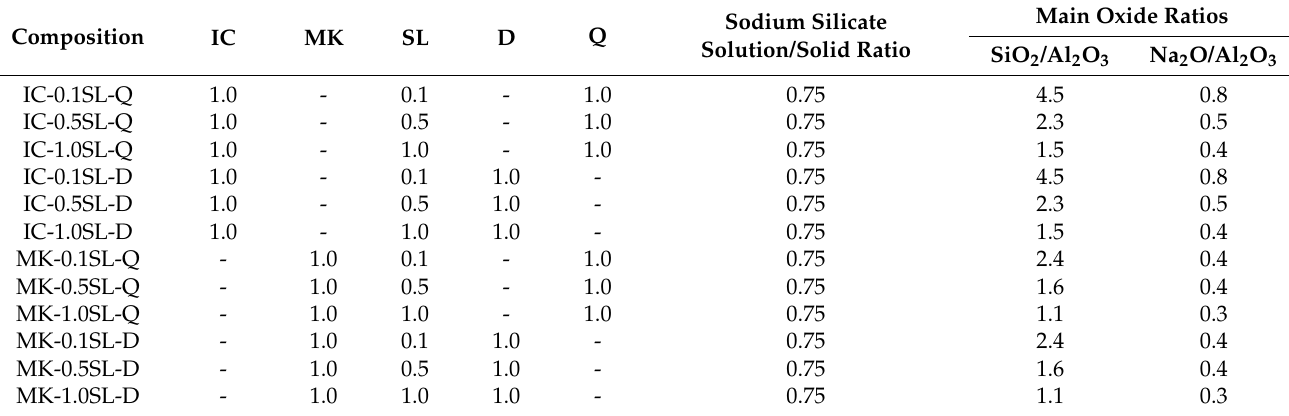
Table 2. Mixture composition of porous geopolymers based on IC and MK